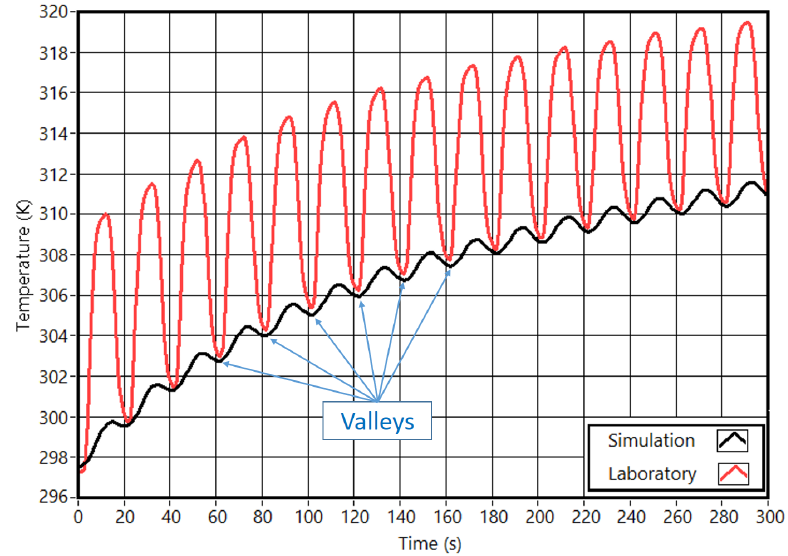
Figure 5. Obtained temperatures in laboratory and simulation at the center of slot